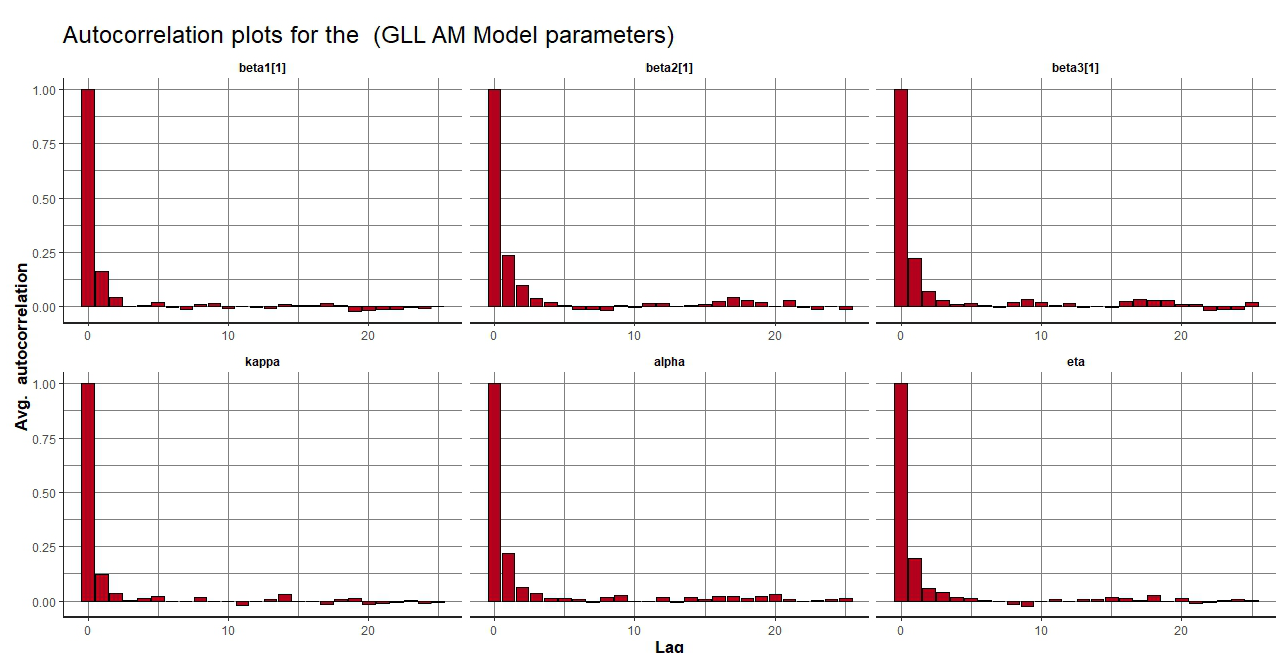
Figure 15. Autocorrelation plots for the GLL − AM model